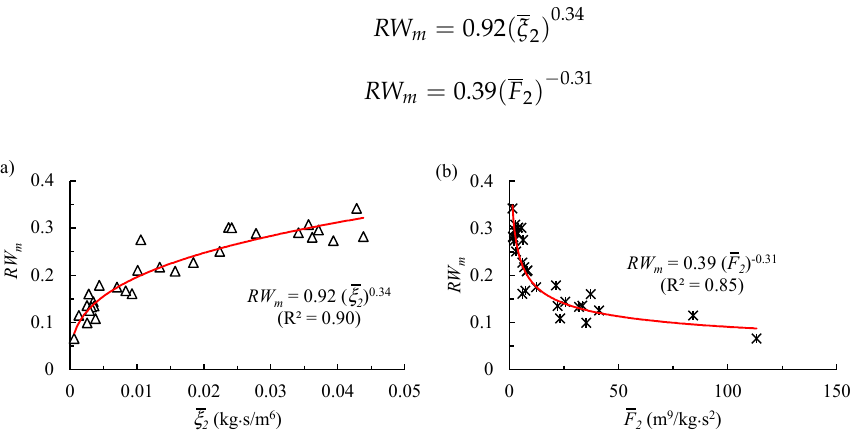
Figure 14. Relationships between the channel migration intensity and various incoming flow-sediment factors of: ( a ) the previous two-year average incoming sediment coefficient ( ξ 2 ); ( b ) the previous two-year average fluvial erosion intensity ( F 2